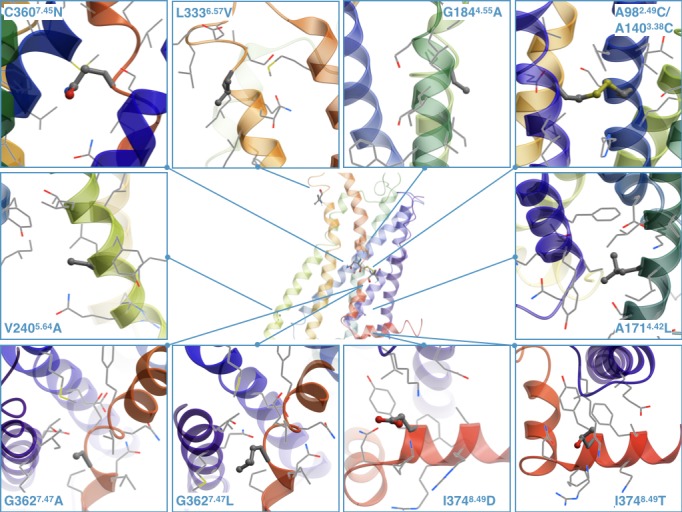
The stabilizing point mutations modeled in the structure of the ritanserin-bound 5-HT2C receptor (the ligand is not shown).Each mutated residue and its neighboring residues are represented as sticks and wires, respectively.